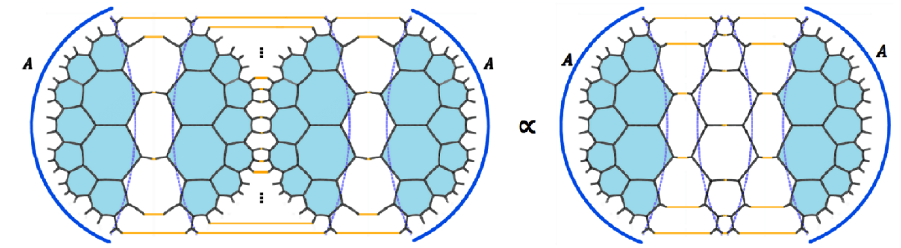
Figure 23 . The diagram for the evaluation of (cid:26) 2